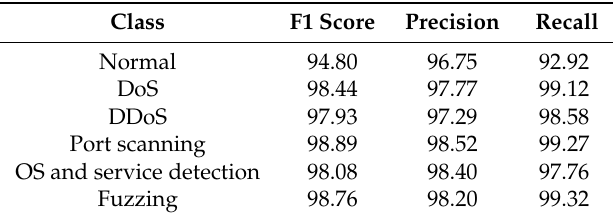
Table 9. Performance of random forest (RF) using 10 best